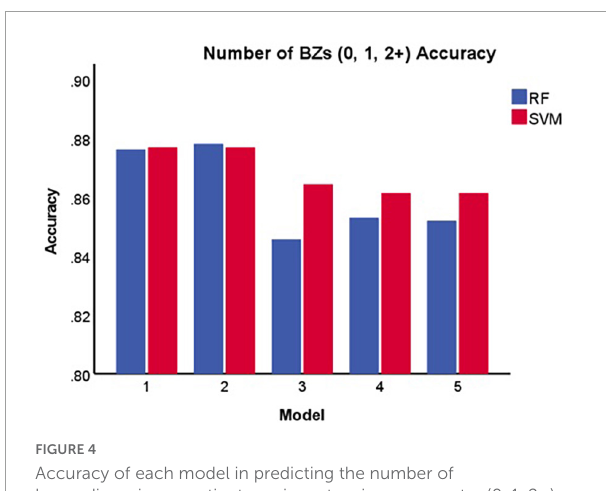
FIGURE4 Accuracy of each model in predicting the number of benzodiazepines a patient receives at a given encounter (0, 1, 2+). BZ, benzodiazepine; SVM, support vector machine; RF, random